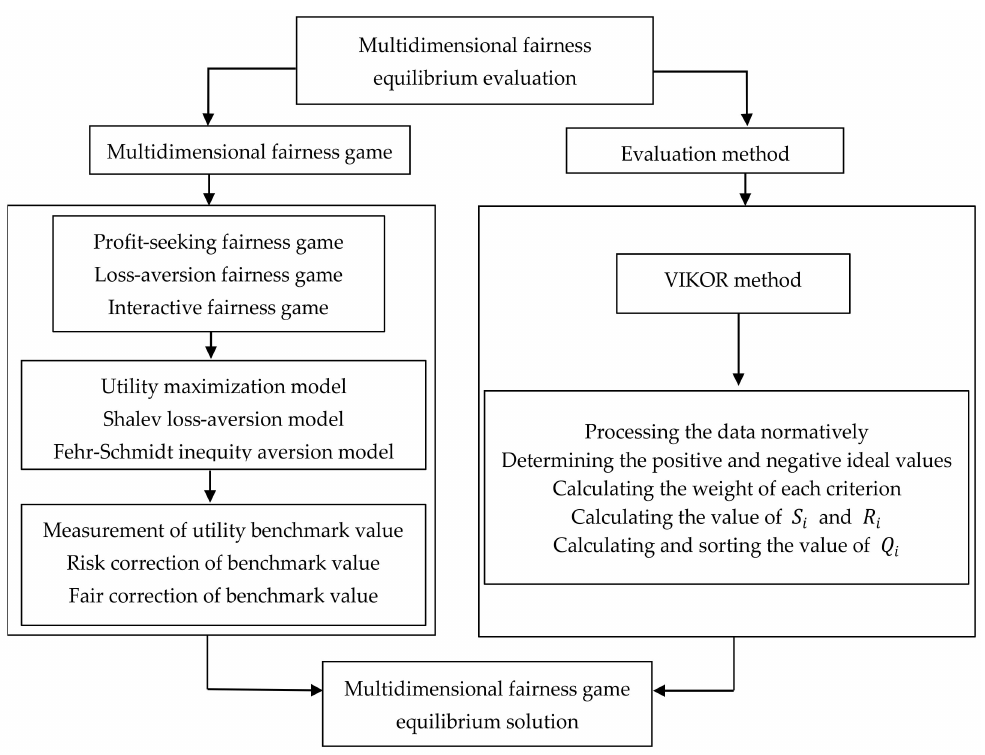
Figure 1. The logic structure diagram of multidimensional fairness equilibrium